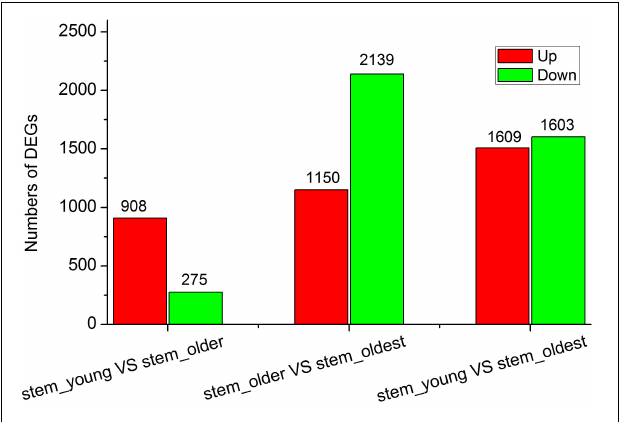
FIGURE 5 | Numbers of DEGs among all comparison group.